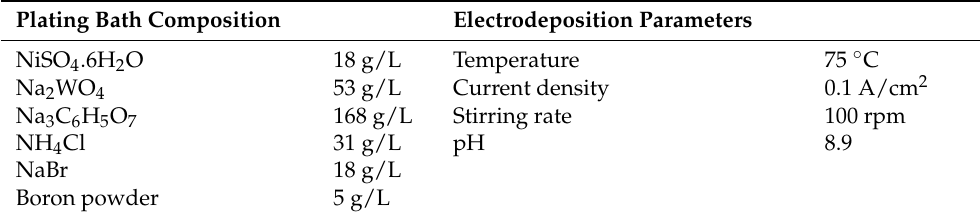
Table 1. Plating bath constituents and the electrodeposition